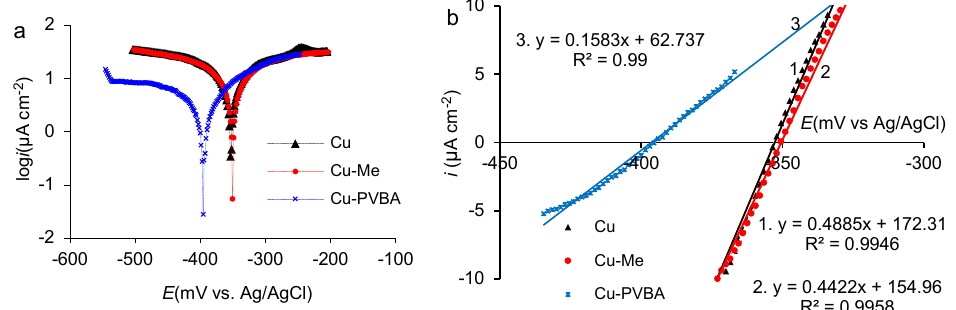
Figure 3. Potentiodynamic polarization curves recorded with a potential scan rate of 1.0 mV s − 1 , on standard copper, methanol-treated copper, and PVBA modified copper, in 0.9% NaCl solution, at room temperature: ( a ) Semilogarithmic curves; ( b ) linear diagram drawn in the potential range close to corrosion potential (± 20 mV).